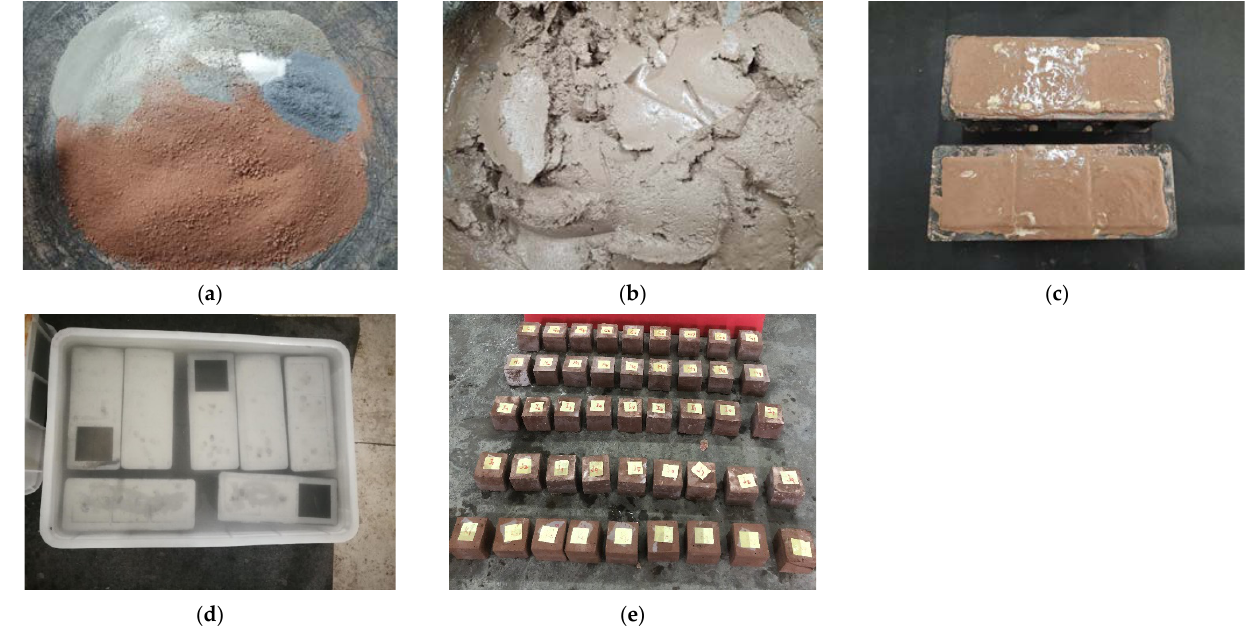
Figure 4. Test sample preparation process. ( a ) Preparing raw materials; ( b ) Mixing with water; ( c ) Puting in the mold; ( d ) Water curing; ( e ) NUC-FM samples. The underwater curing process of the NUC-FM has obvious white transparent gel material precipitation, which increases gradually with increasing curing time. After 12 h of underwater curing, the amount of white precipitated gel was basically stable, and an isolation layer was formed on the surface of the NUC-FM.